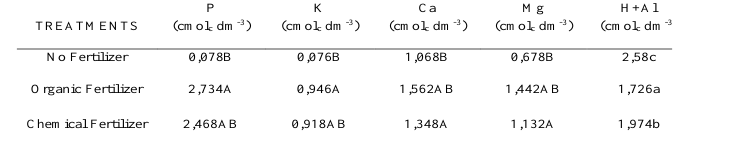
Table 4: Comparison between the means of the variables obtained in the sixth month of planting for Phosphorus (P), Potassium (K), Calcium (Ca), Magnesium (Mg) and Potential Acidity (H + Al) on the soil in the application of the three treatments studied.